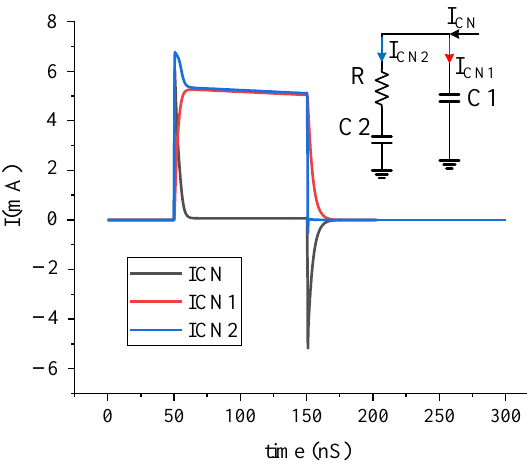
Figure 5. The simulation result of the ICN of the loop filter.